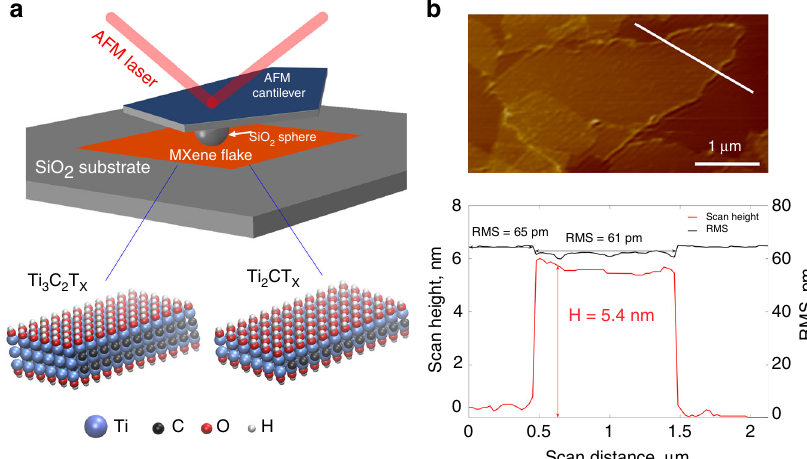
Fig. 1 a Schematic representation of AFM indentation experiment, b AFM image and surface pro fi le along the white line across the Ti 3 C 2 T x fl ake deposited on SiO 2 coated Si